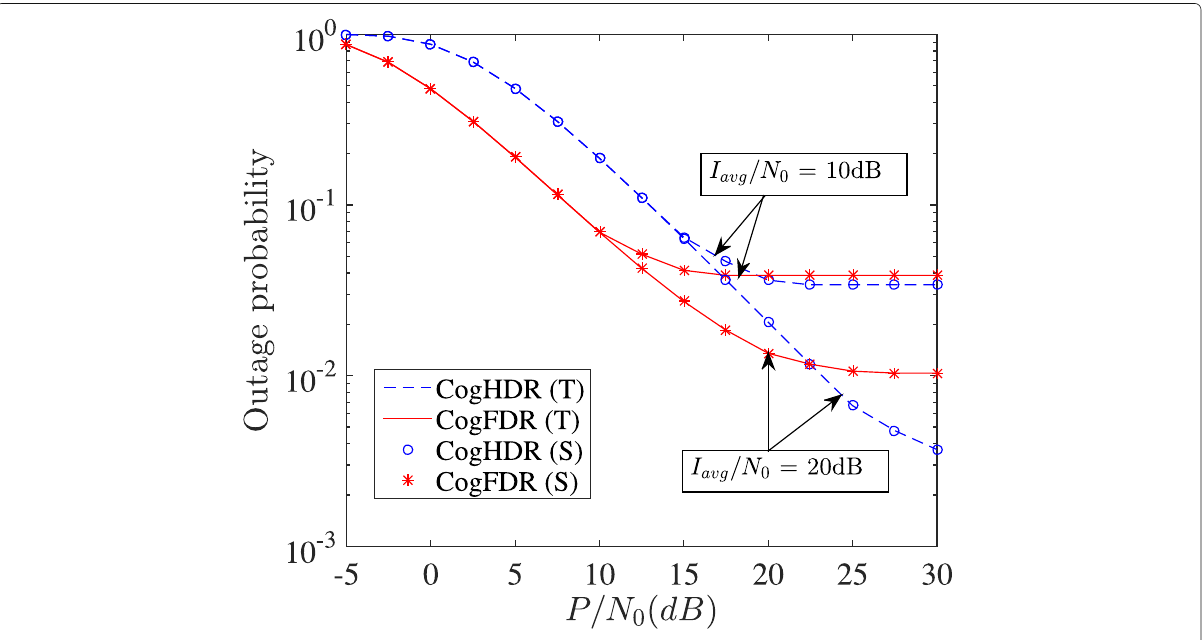
Fig. 2 Outage probability vs. P / N 0 for I avg / N 0 = 10 dB and 20 dB ( λ rr = − 40